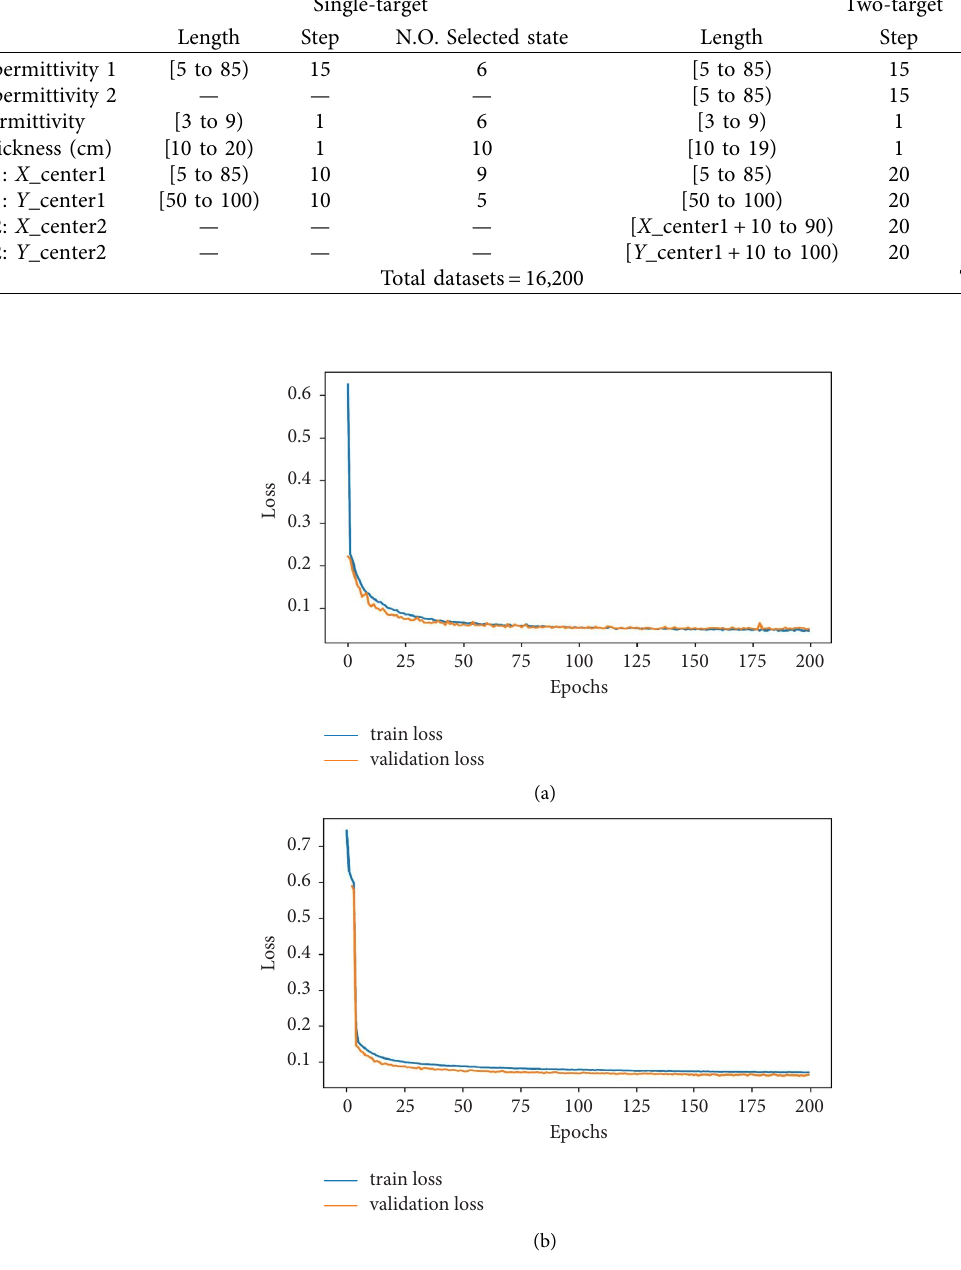
Figure 3: Loss diagrams in single-target and two-target locating. (a) Single-target loss. (b) Two-target Table 2: Accuracy and loss results for diferent scenarios on evaluation and testing datasets.